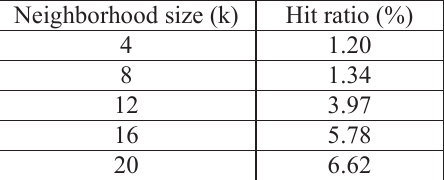
Table 1. Neighborhood size vs Hit ratio